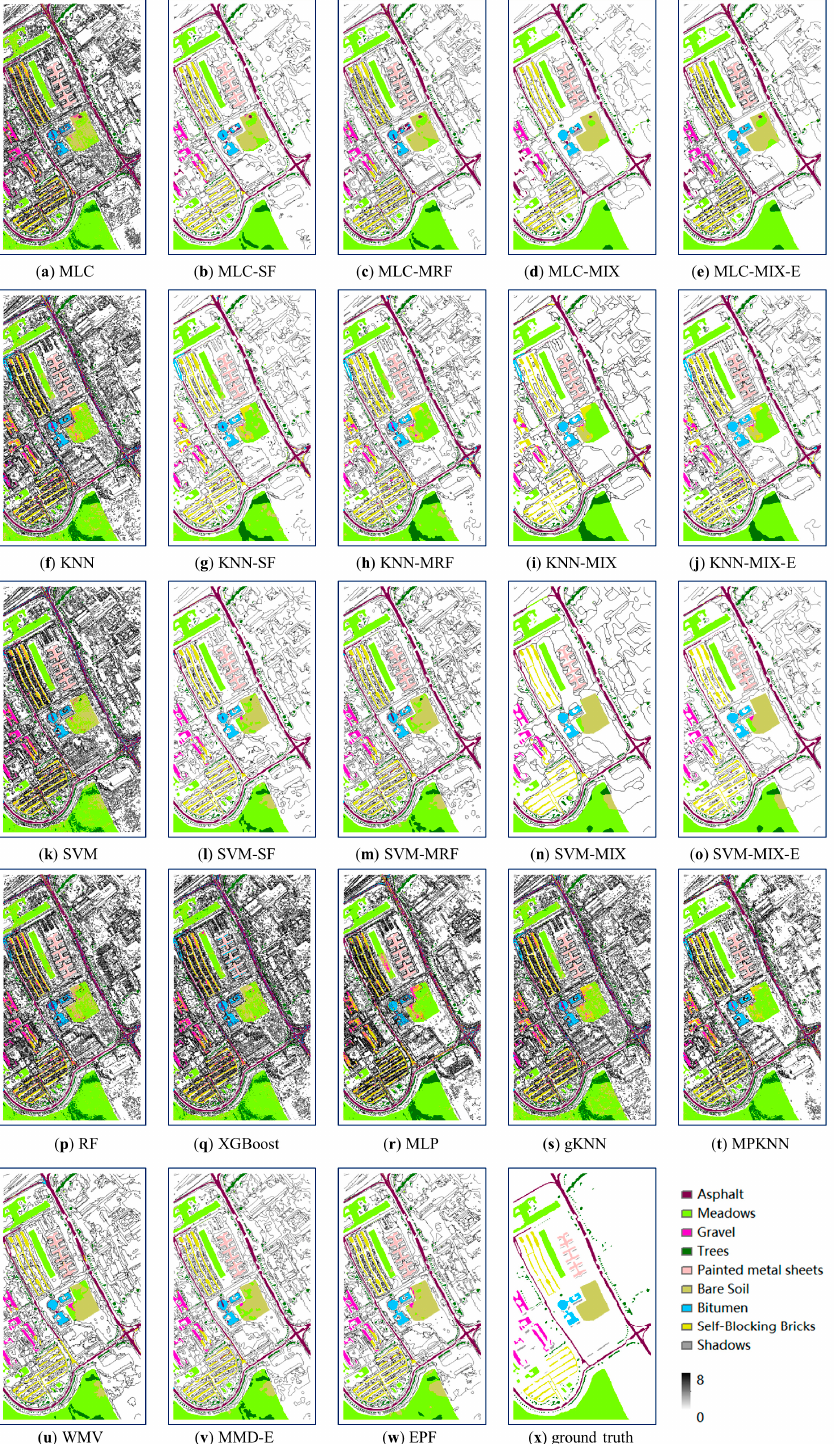
Figure 4. Classification results using different methods for the ROSIS image: ( a ) MLC, ( b ) MLC-SF, ( c ) MLC-MRF, ( d ) MLC-MIX, ( e ) MLC-MIX-E, ( f ) KNN, ( g ) KNN-SF, ( h ) KNN-MRF, ( i ) KNN-MIX, ( j ) MLC-MIX-E, ( k ) SVM, (l) SVM-SF, ( m ) SVM-MRF, ( n ) SVM-MIX, ( o ) SVM-MIX-E, ( p ) RF, ( q ) XGBoost, ( r ) MLP, ( s ) gKNN, ( t ) MPKNN, ( u ) WMV, ( v ) MMD-E, ( w ) EPF, and ( x ) ground-truth.